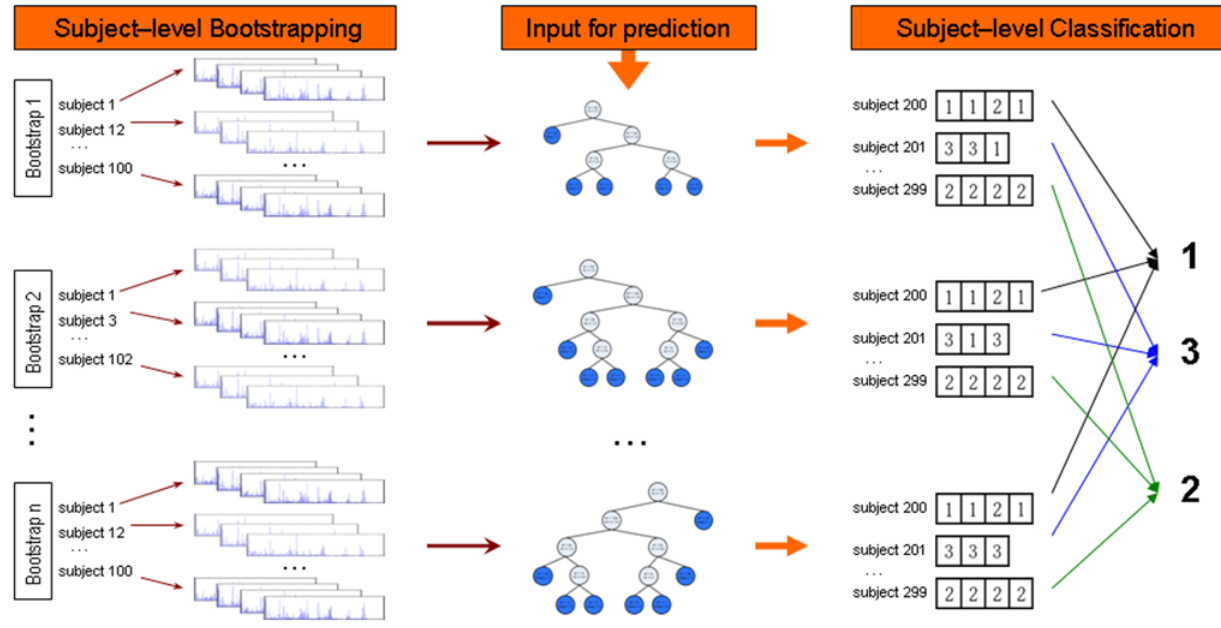
Figure 5. RF ++ outline. Each tree is grown on a different subject-level bootstrap set of samples (left) producing a forest (middle). New subject samples are piped down the forest and each tree casts a vote for each sample. A subject classification is computed as the class with the maximum number of votes across all samples for that subject among all trees (right). Proportions of votes for each class are also produced.